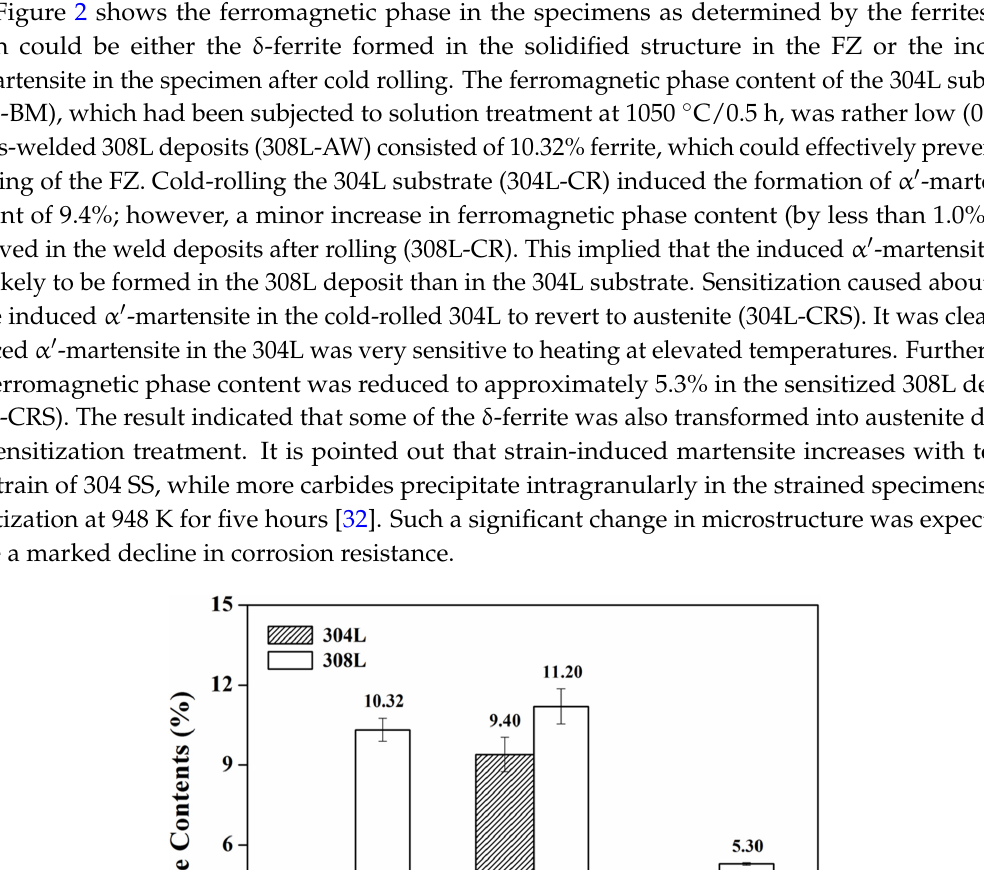
Table 3. Average Vickers ‐ Hardness of the various specimens.